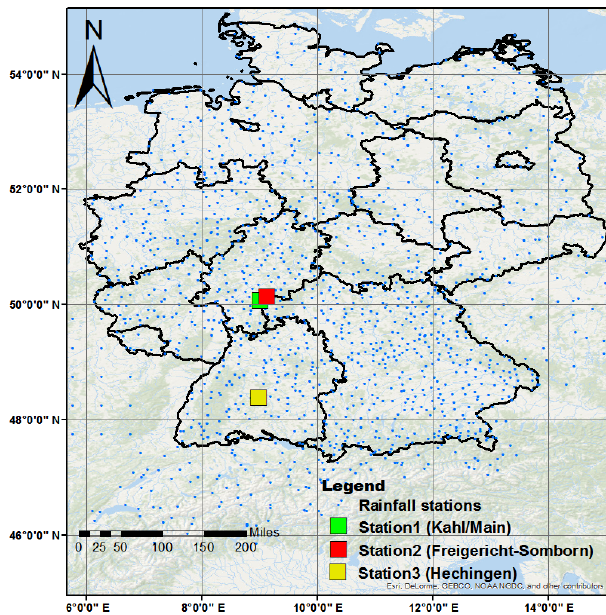
Figure 5. Geographical locations of rainfall stations considered in case study